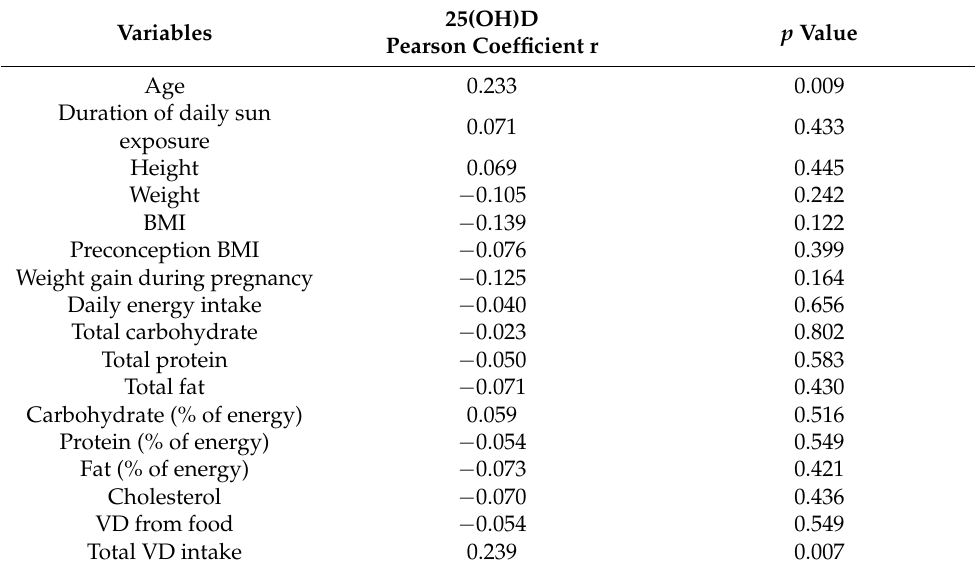
Table 2. Correlation of 25(OH)D levels before delivery with study